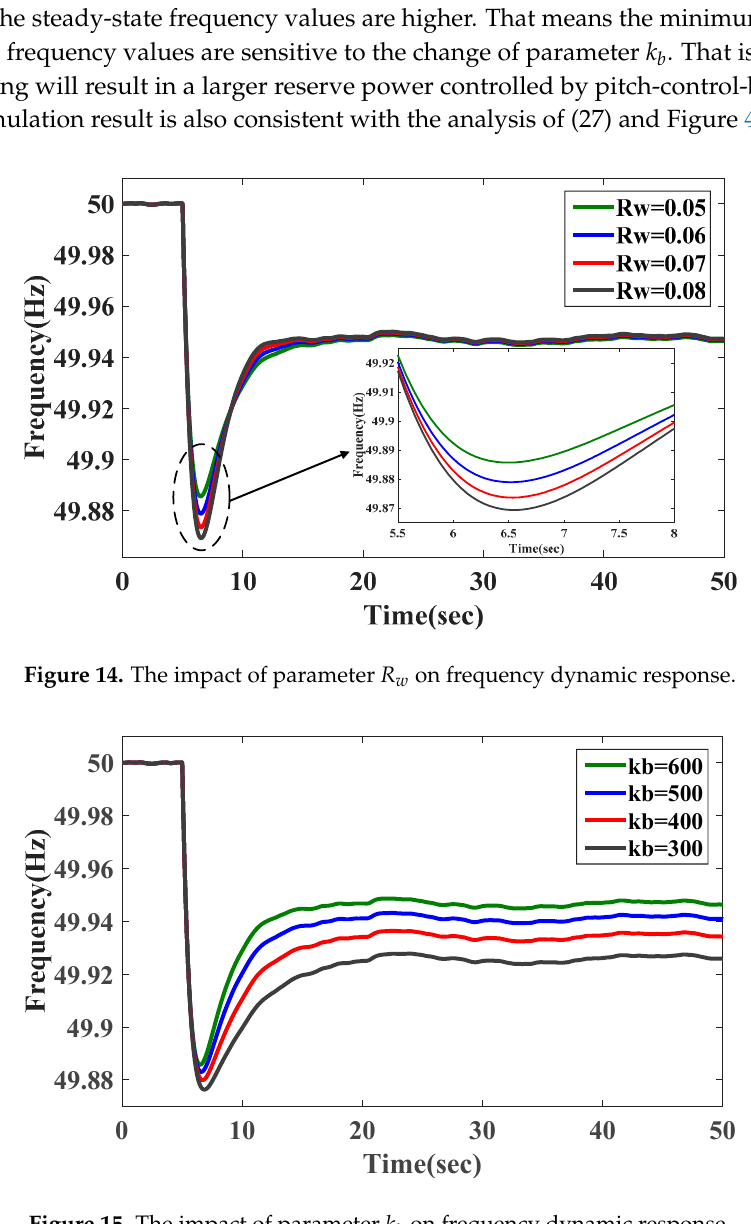
Figure 13. The impact of parameter k w on frequency dynamic response.